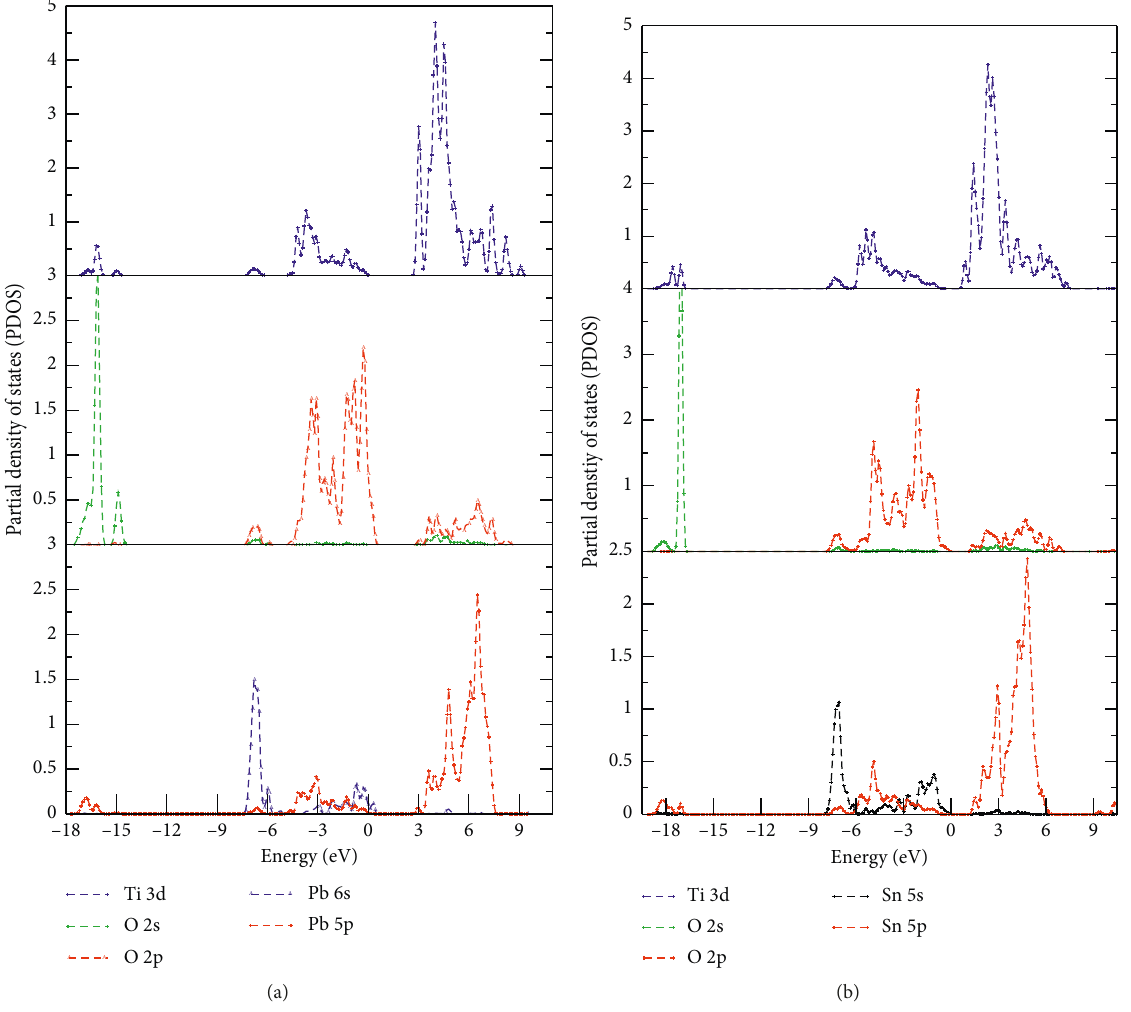
Figure 6: Partial density of states of (a) PbTiO